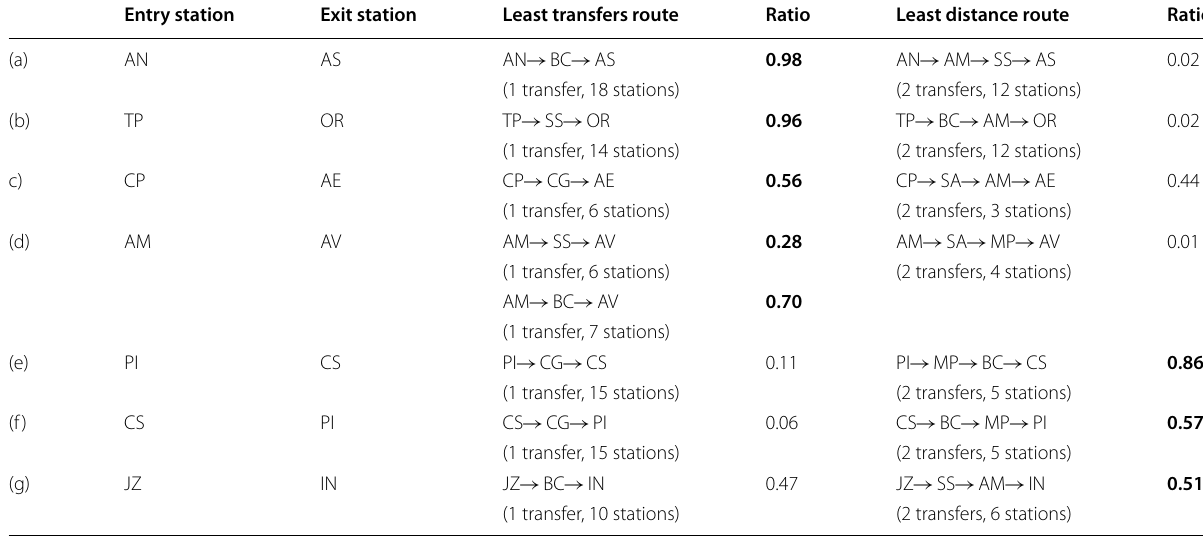
Bold values indicate larger percentage